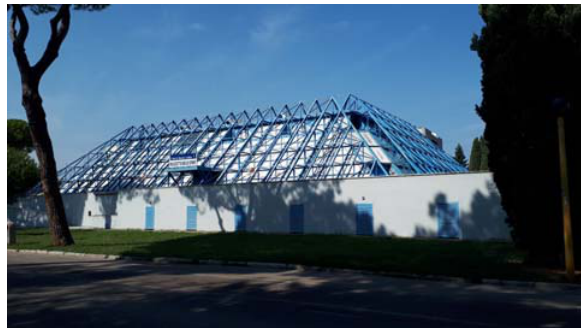
Figure 2 . The current state of the Sports Hall built in 1983.